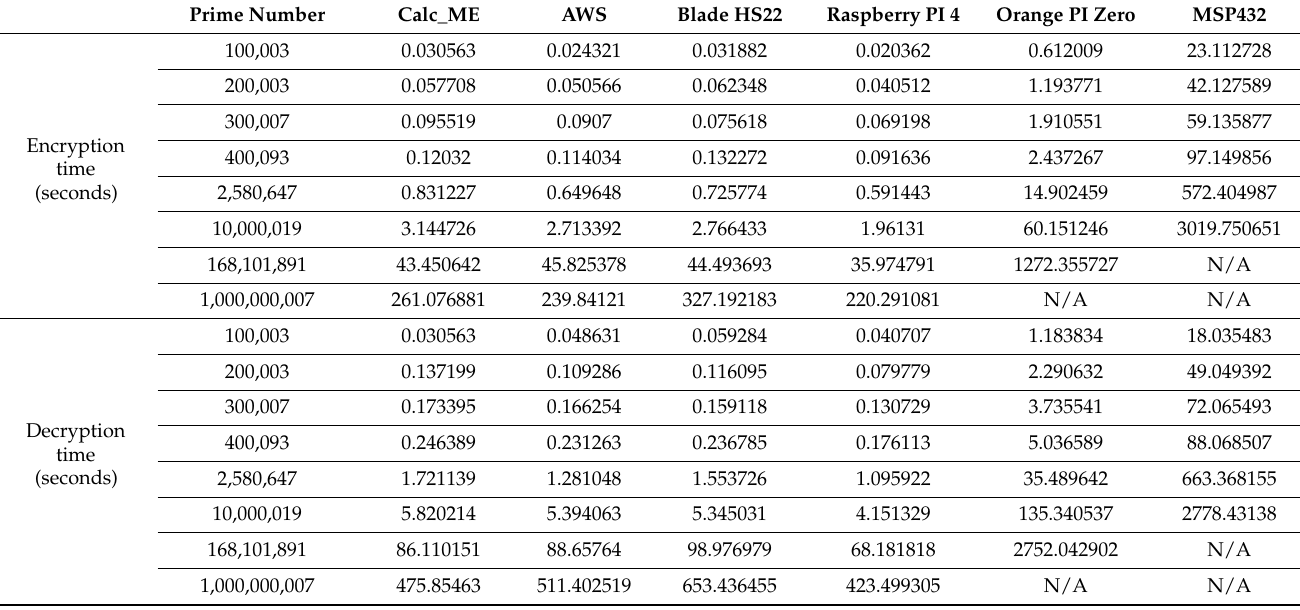
Table 4. Encryption/decryption times elapsed for generating 101 keys with different values of the chosen prime number p